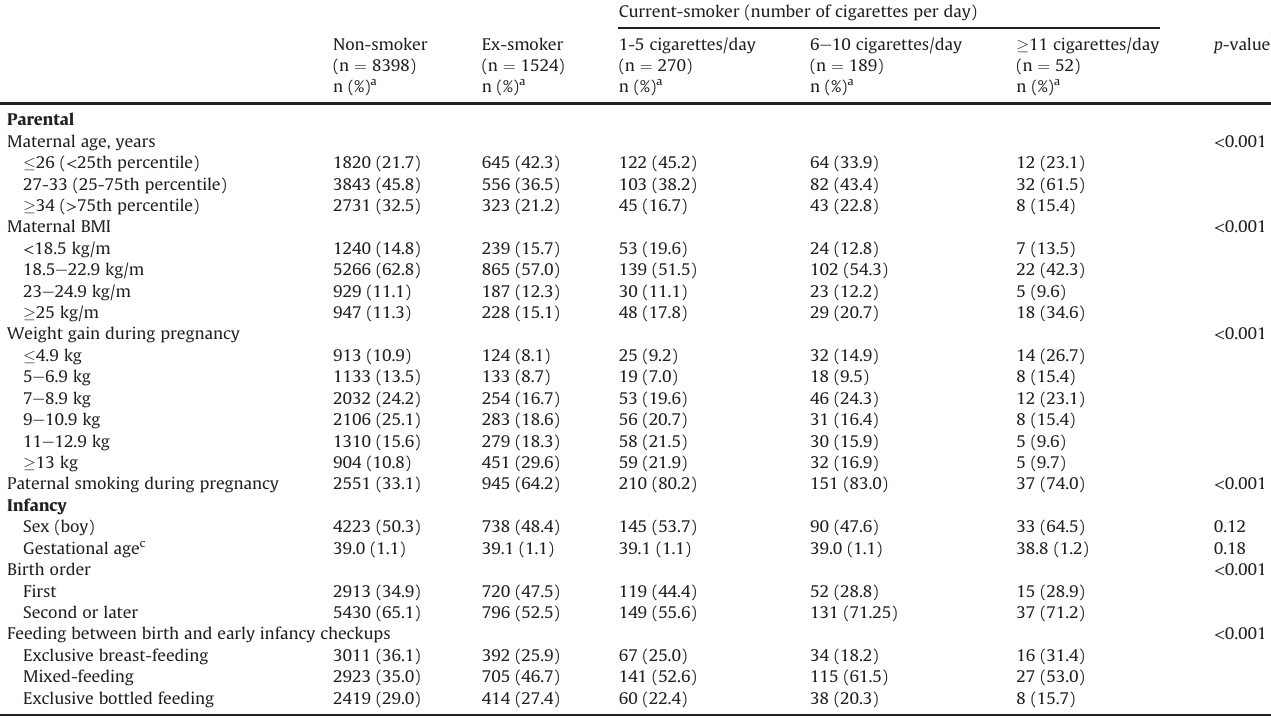
BMI, body mass index. Due to missing values, the totals for the strati fi ed subgroups are not equal. a Column %. b p-value for c 2 test or Analysis of variance or Fisher's exact test. c Mean (standard